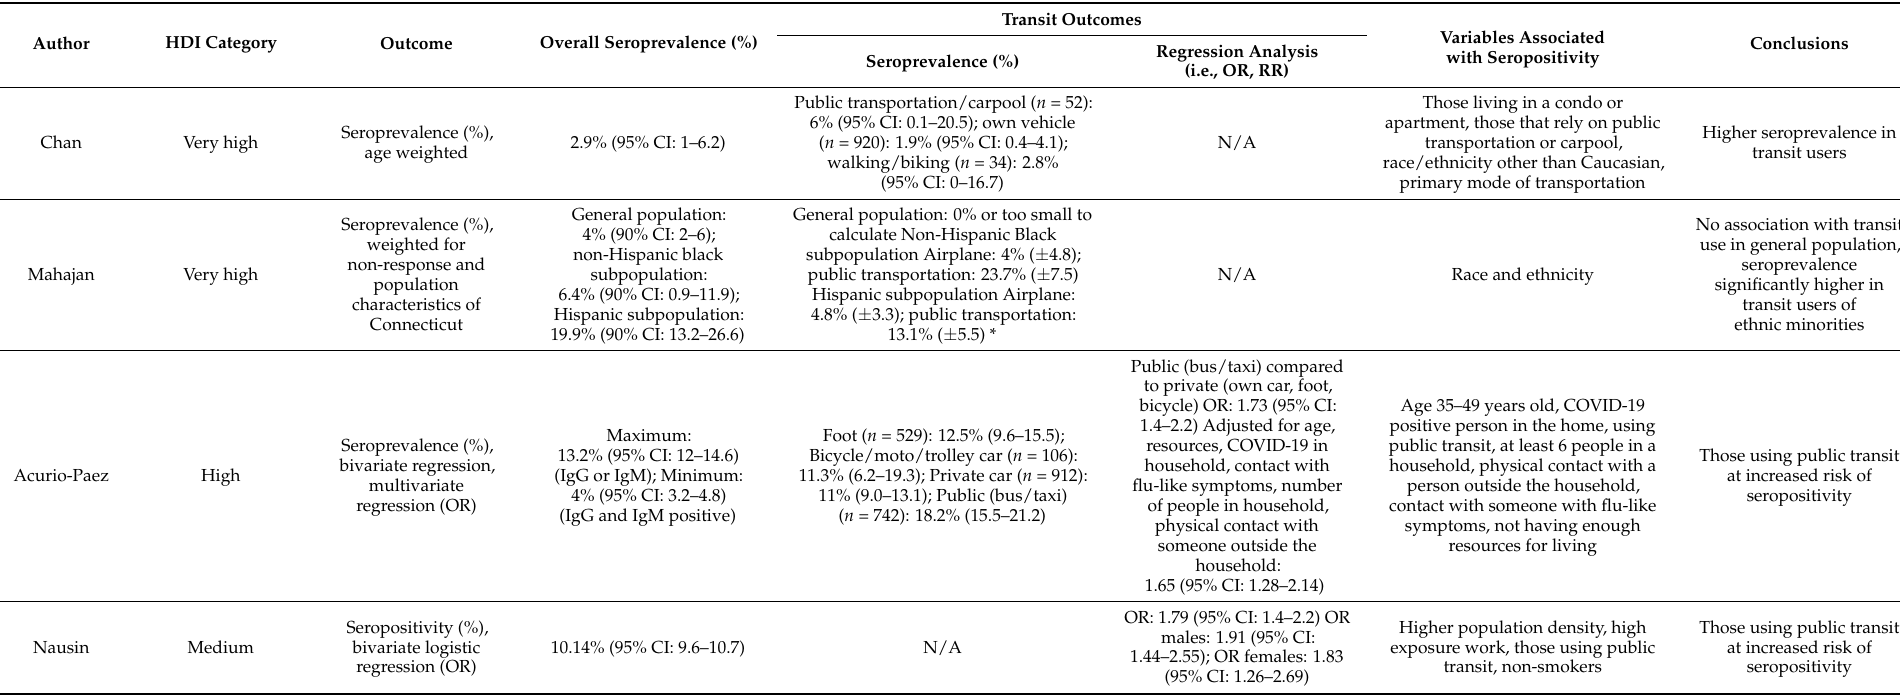
Table 4. Summary of findings from studies that assessed the association between seropositivity and use of public transportation in population-based studies from highest to lowest